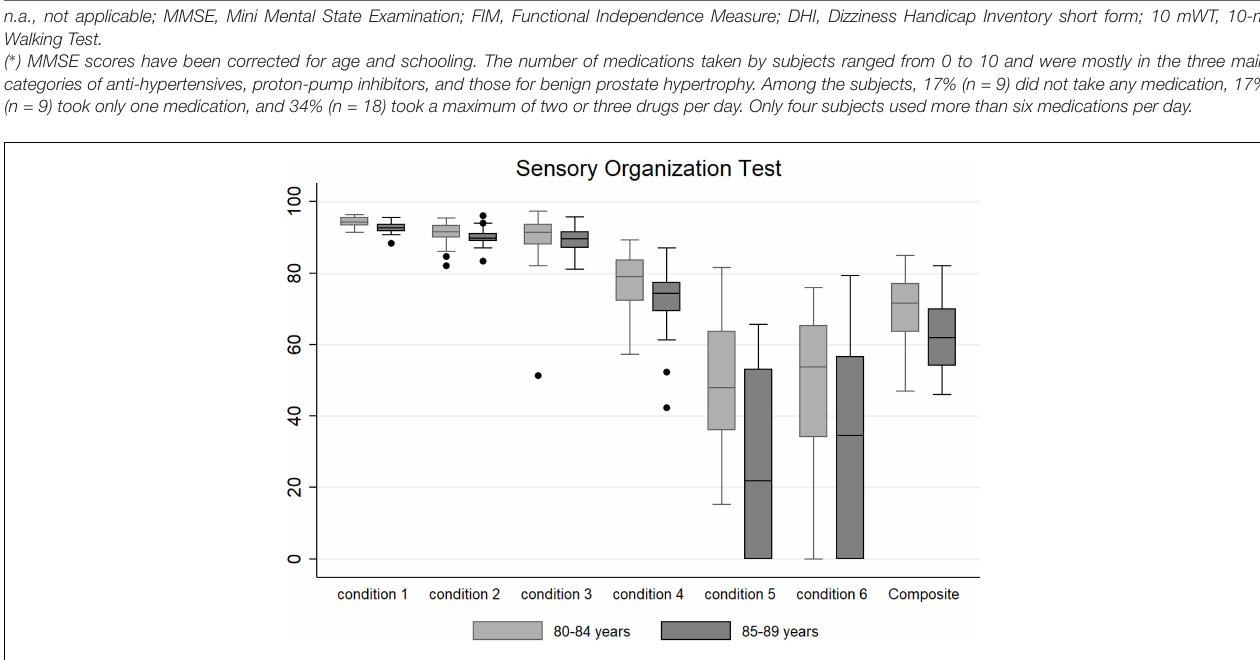
FIGURE 1 | Box plots (median and interquartile range; outliers are represented as dots) for the six testing conditions and for the composite Sensory Organization Test for the very old (80–84 years) and oldest old (85–89 years)